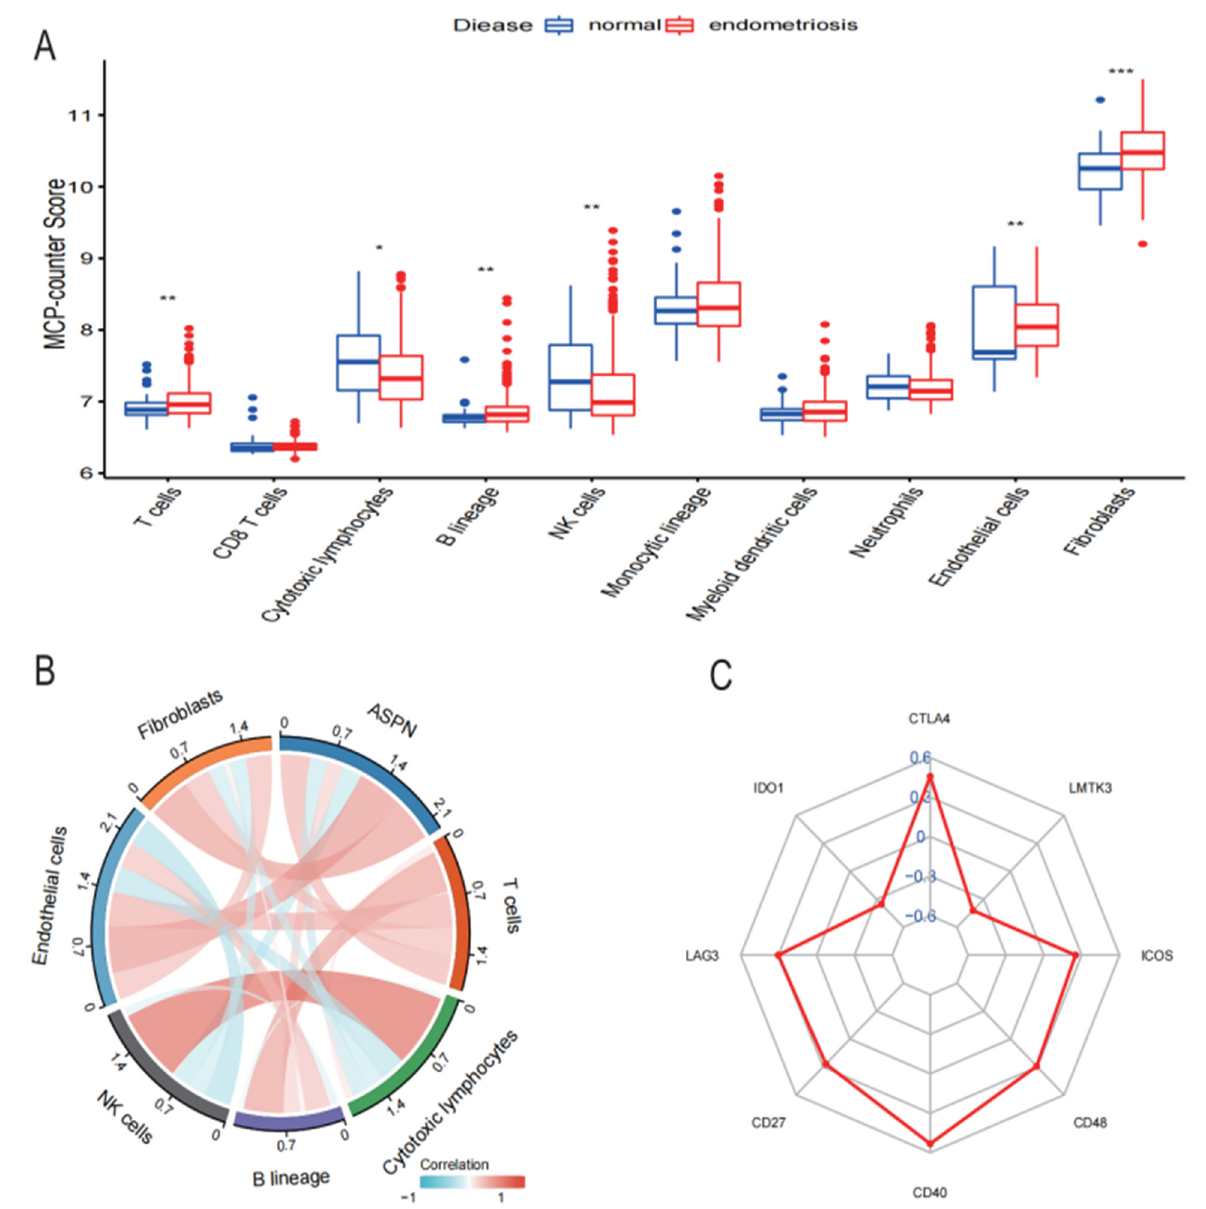
Figure 7. Distribution of immune cell infiltration and correlation analysis. ( A ) The composition of immune cells in endometriosis tissues and normal control tissues. ( B ) Analysis of the correlation between ASPN and immune cells invading endometriosis. ( C ) The relationship between the immune checkpoint genes and ASPN (* p < 0.05, ** p < 0.01, *** p < 0.001).